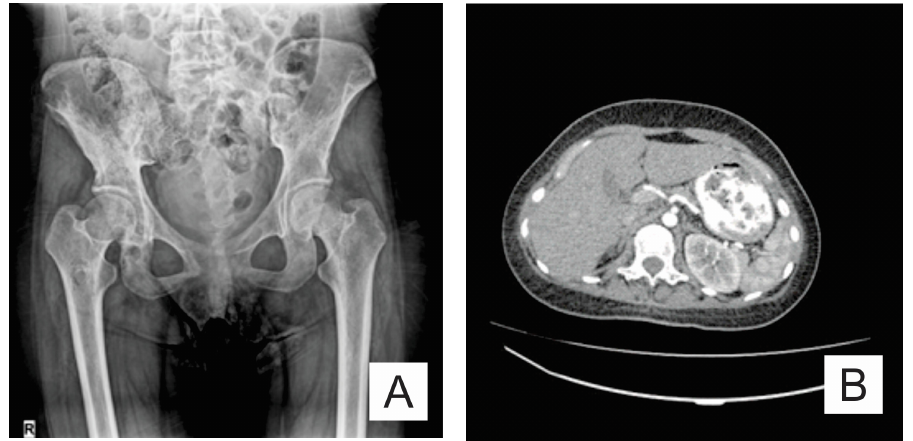
Figure 4. ( A ) Pelvis X-ray (AP view): osteolysis areas in the lumbar vertebrae, pelvic bones and the bilateral proximal femur; and ( B ) axial CT scan: multiple splenic nodules.